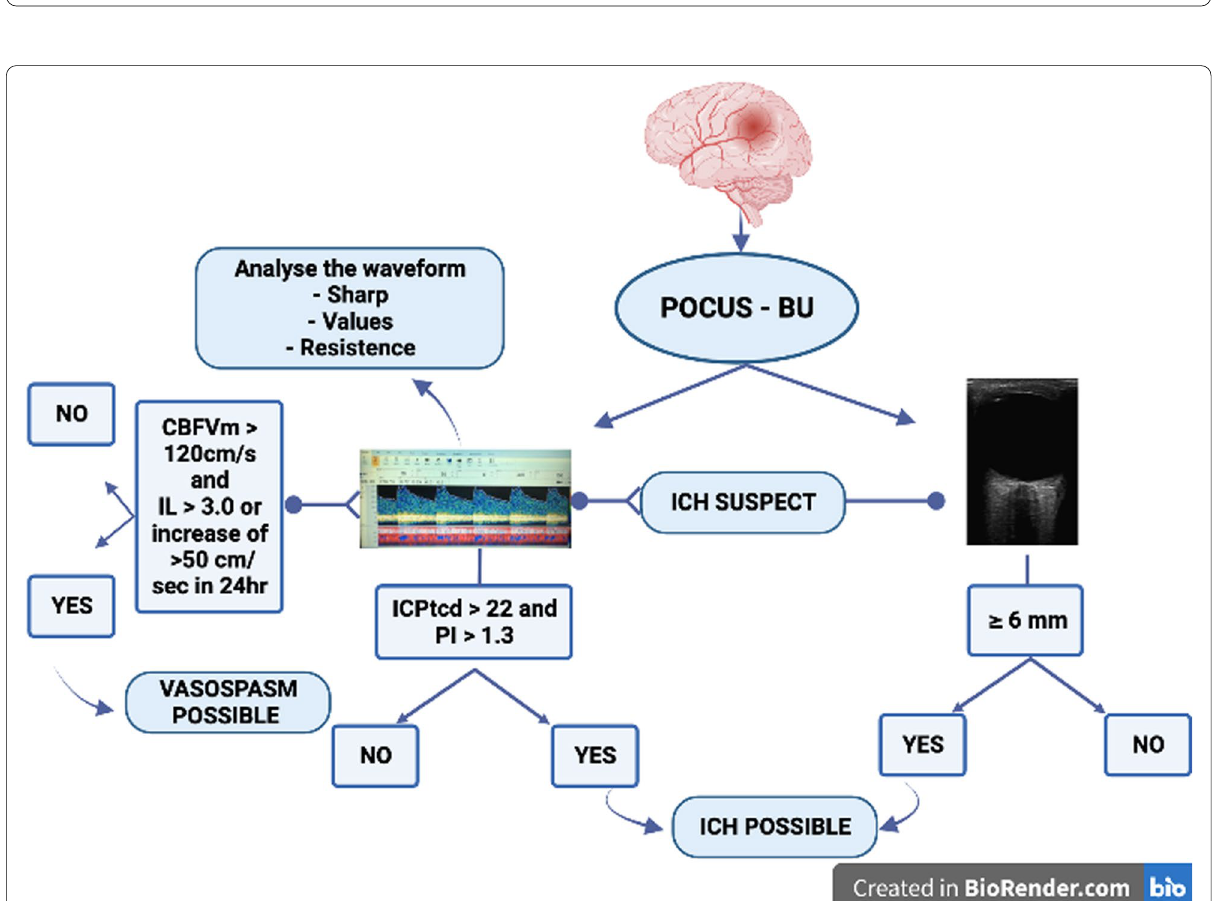
CBFVm of middle =